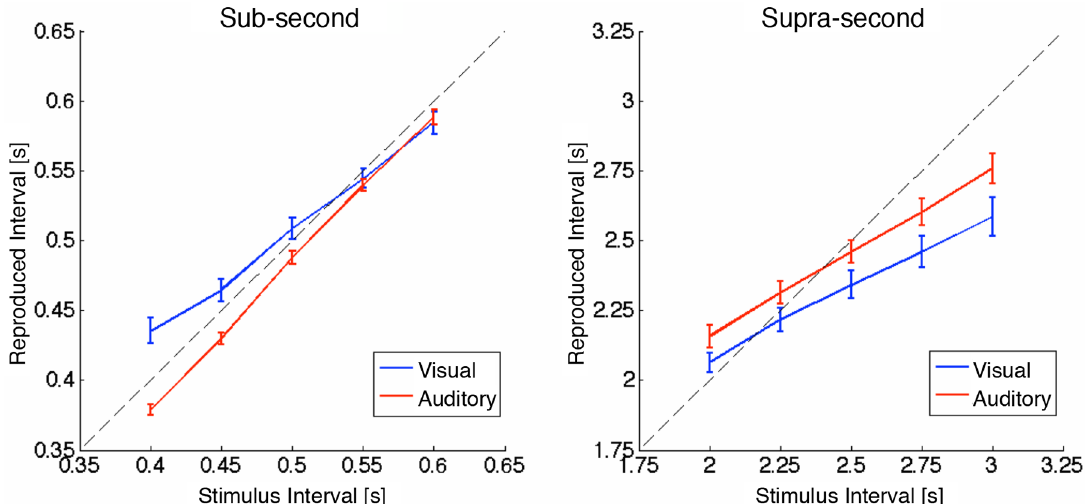
Fig 2. Group means of the reproduced intervals. The left panel indicates the results for sub-second timing. The right panel indicates the results for supra-second timing. Blue lines represent results for visual stimuli, and red lines represent results for auditory stimuli. Dotted lines correspond to accurate reproduction of the stimulus intervals. Error bars represent the standard error of the mean.